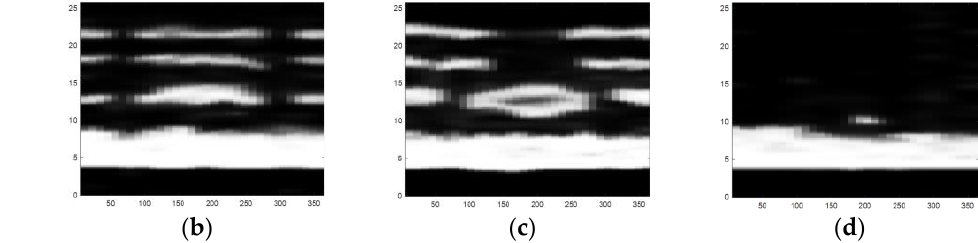
Figure 10. The defect images processed by bilateral filtering: ( a ) small crack, ( b ) transverse crack, ( c ) hole defect, and ( d ) chapped defect.